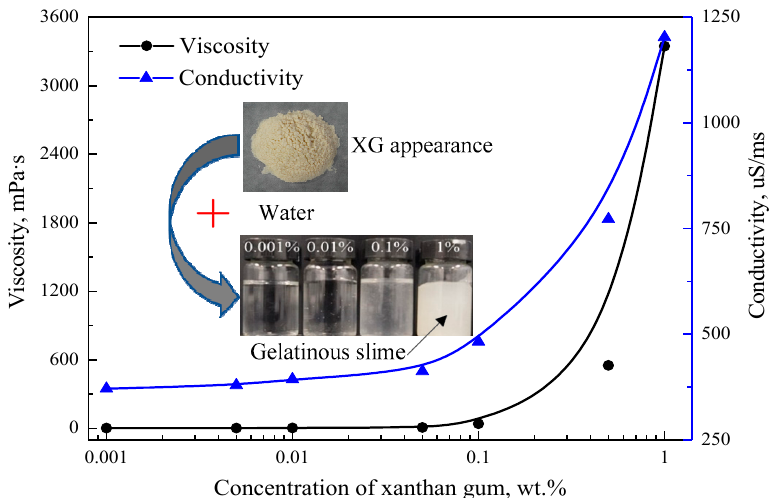
Figure 9. Parameter characterization of XG.